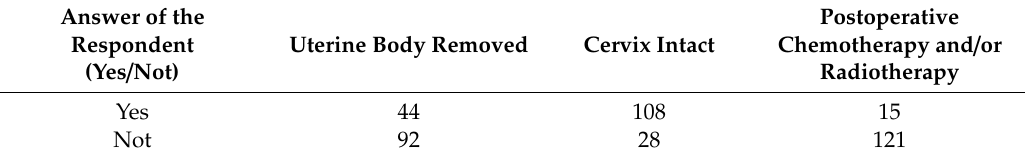
Table 2. Distribution of patients taking into account surgical data.